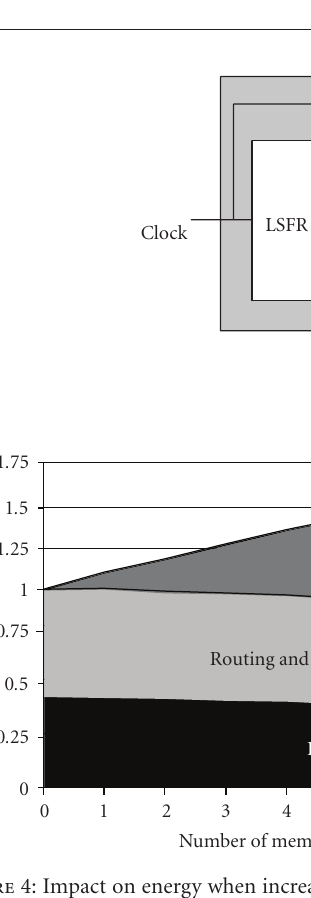
Figure 4: Impact on energy when increasing the number of mem- ory arrays (512-bit arrays in VPR flow).